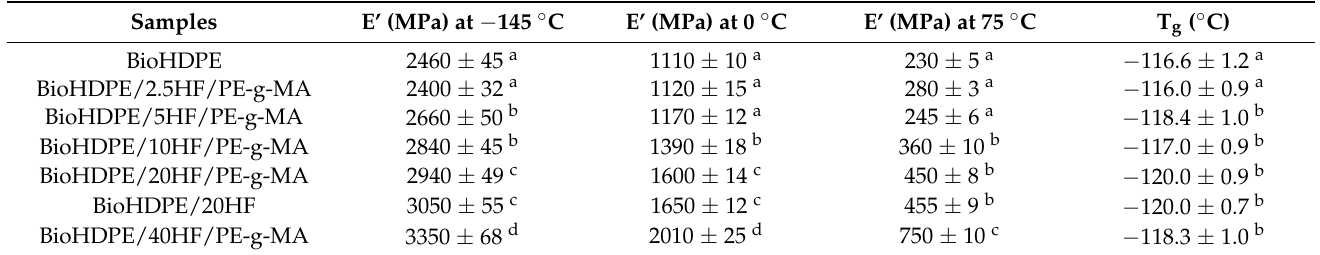
Table 6. Main thermomechanical properties of Bio-HDPE/Hemp fiber composites obtained by dynamic mechanical thermal analysis